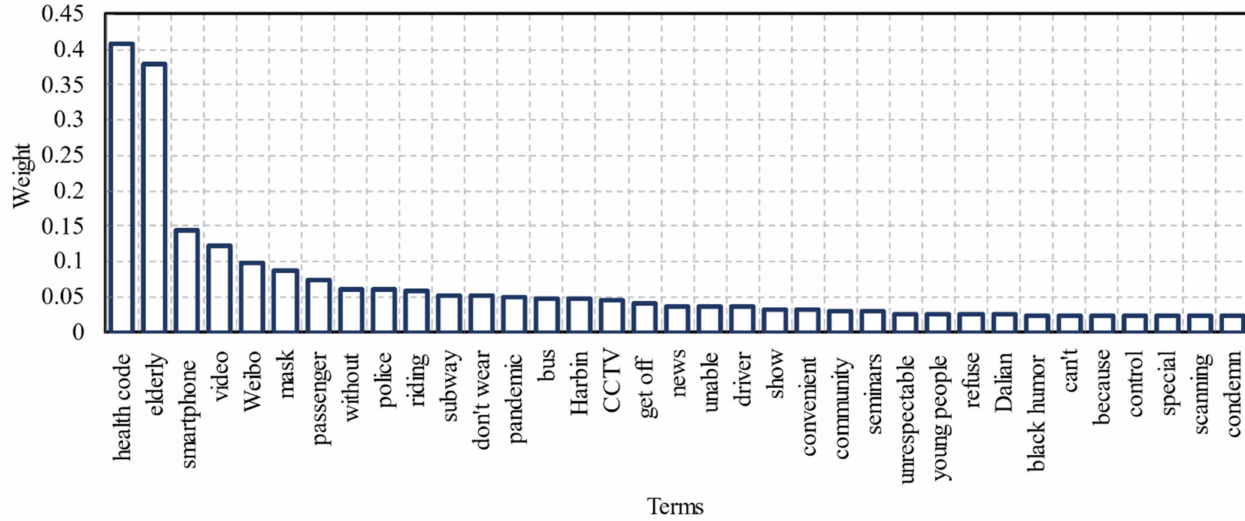
Figure 7. Top 35 most important words in public communication. The weights represent the importance of the terms and the bar with the highest weight indicates that it is the primary focus of public